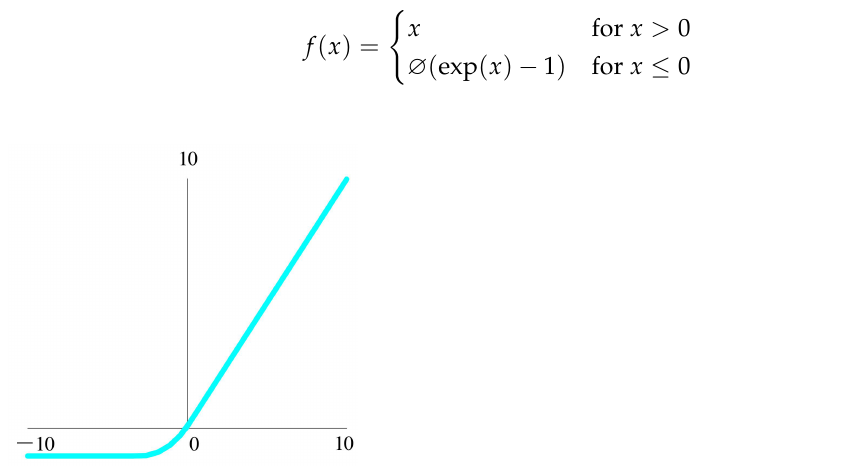
Figure 13. The function of the exponential linear